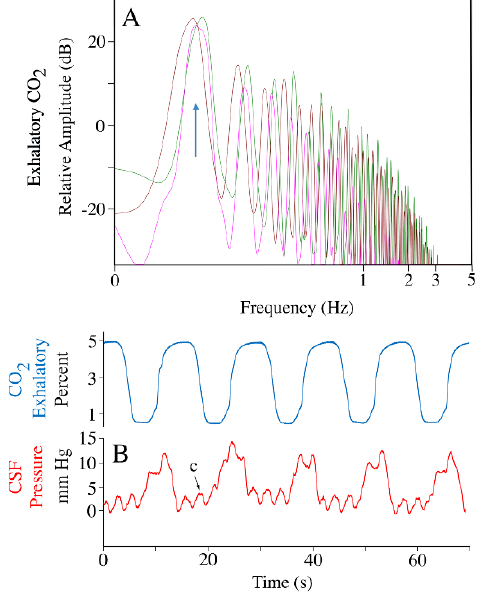
Figure 2. Exhalatory CO 2 and ventilatory-related csf pressure pulsations. ( A ) Power spectral analyses of the exhalatory CO 2 traces from three individuals of Alligator mississippiensis (individuals’ traces are color-coded), all have a dominant frequency near 0.08 Hz (vertical arrow) corresponding to a ventilatory rate of 5 breaths per minute. ( B ) Simultaneously recorded exhalatory CO 2 (blue) and CSF pressure (red) tracings, showing the distinction between the ventilatory- and cardiac-related CSF pressure pulses. c—individual cardiac-related pulsation.